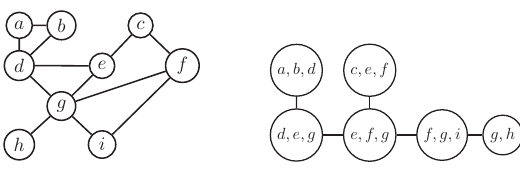
Figure 1. Graph G and its tree